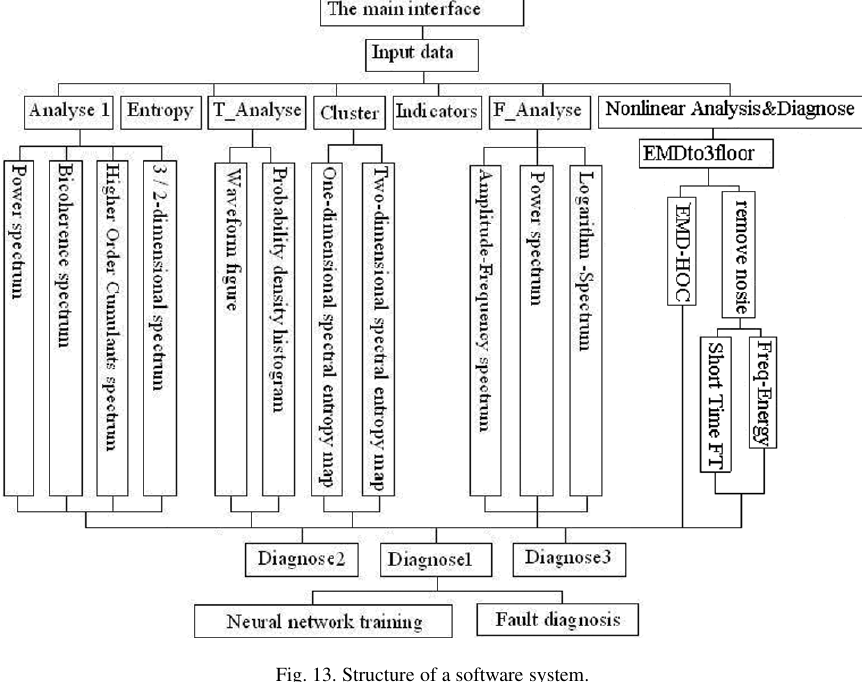
Fig. 13. Structure of a software system.